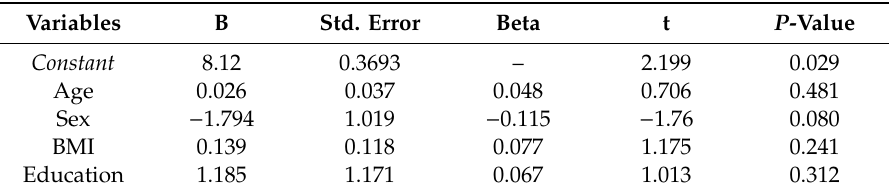
Table 2. Multiple linear regression analysis 1